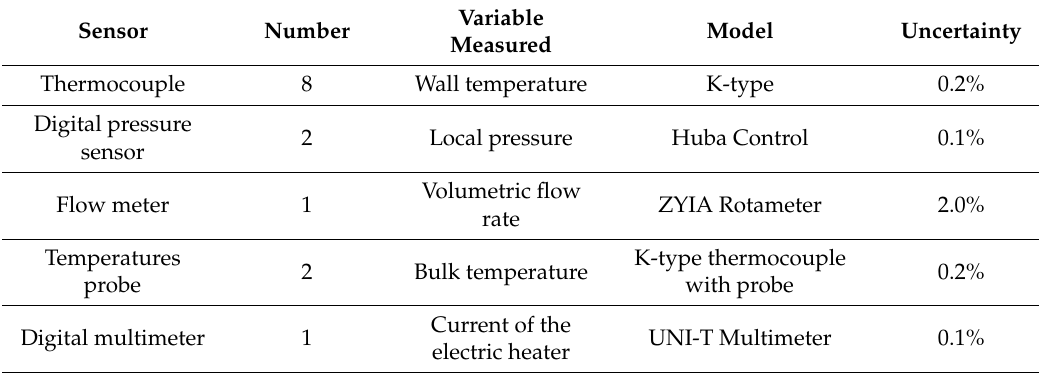
Table 5. Uncertainty of experimental